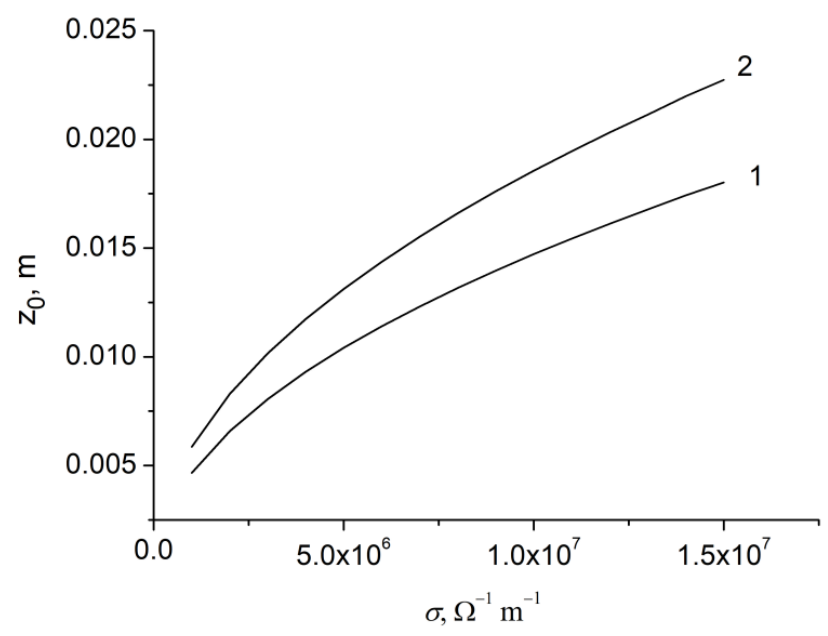
Figure 5. The phase velocity ( a ) and attenuation length ( b ) as a function of frequency. 𝑟 0 = 10 μm, σ = 1.5 ∙ 10 7 Ω −1 m −1 .